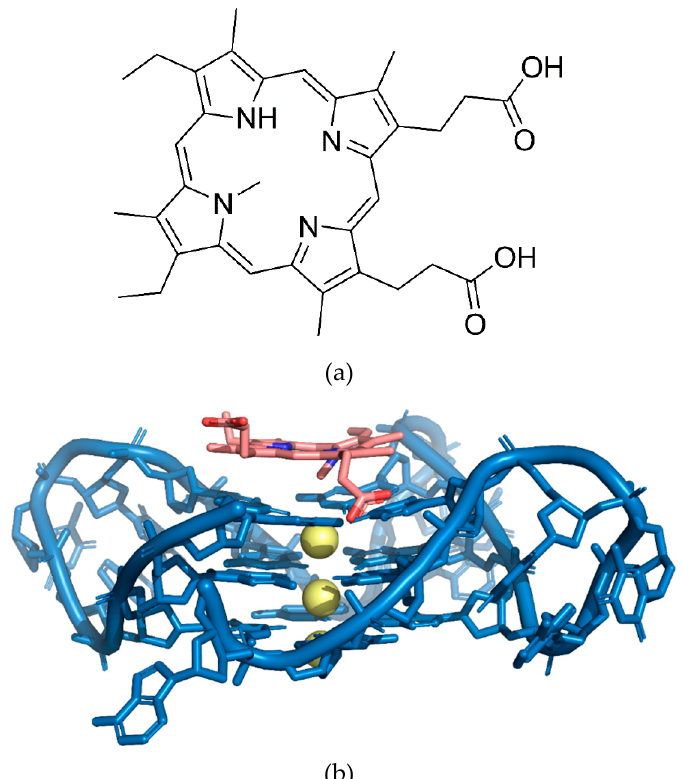
Figure 18. ( a ) Chemical structure of N -methylmesoporphyrin IX (NMM). ( b ) Structure of the complex of G-quadruplex and N -methylmesoporphyrin IX (NMM) (PDB: 4FXM).